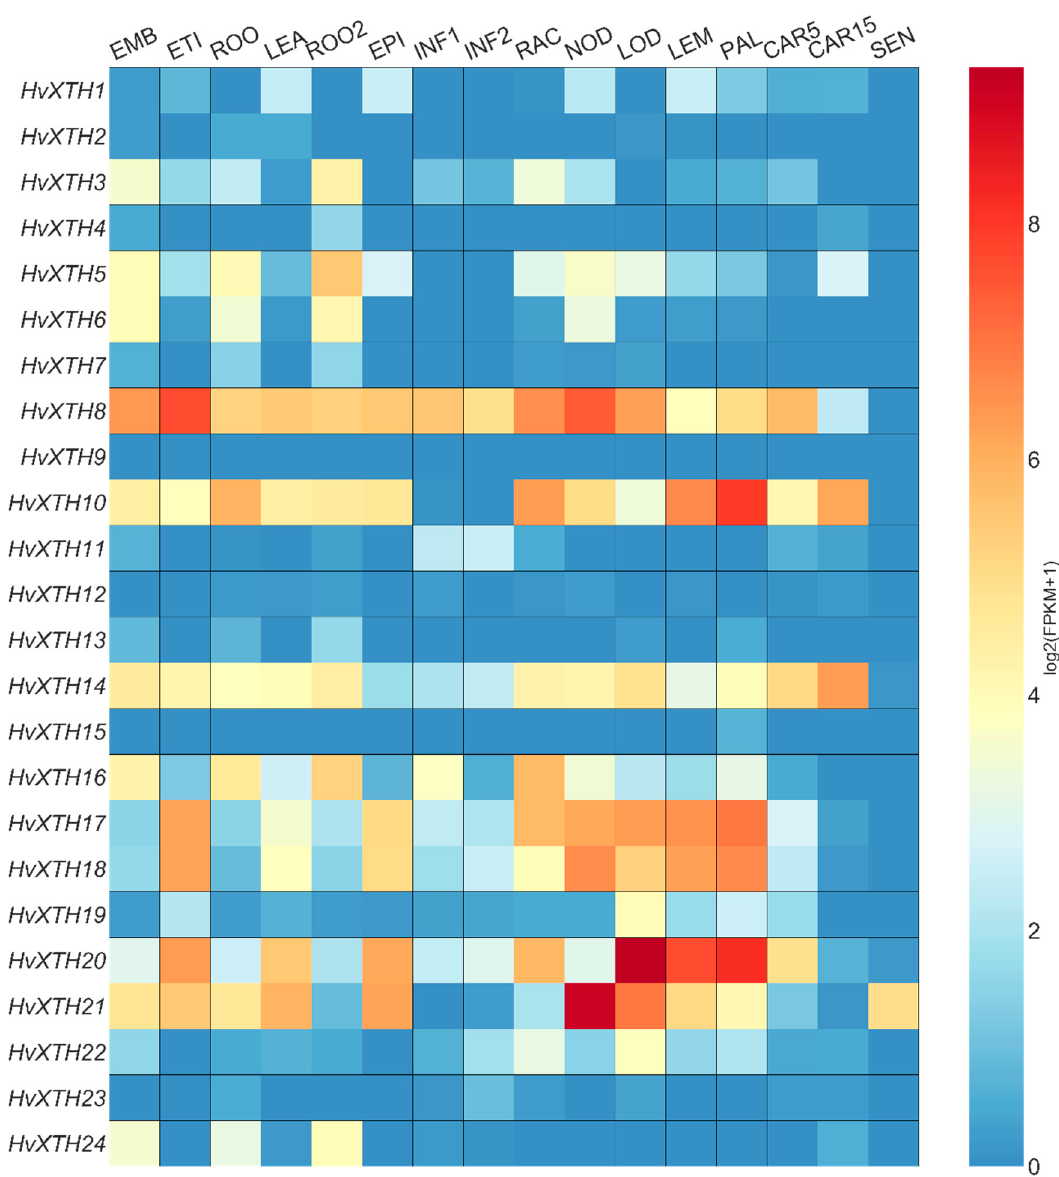
Figure 5. Heatmap of HvXTH gene expression in different tissues and stages of development. Data were obtained from a publicly available database, ENA (Accession number: PRJUEB3149, PRJEB14349). Rows represent HvXTH members, while columns show different developmental stages and tissues. The expression level of HvXTHs (log 2 (FPKM + 1)) is shown by the intensity of color. EMB, embryonic tissue; ETI, isolate etiolated leaf; ROO, root tissue (17 days and 28 days after planting); LEA, leaf tissue; EPI, epidermal strips; INF, whole developing inflorescence tissue (30 days and 50 days after planting); RAC, rachis; NOD, third stem internode; LOD, isolate lodicule dissected from inflorescences; LEM, lemma dissected from inflorescences; PAL, palea dissected inflorescences; CAR, whole developing grain (caryopsis, 5 and 15 days post-anthesis); SEN, senescing leaf.